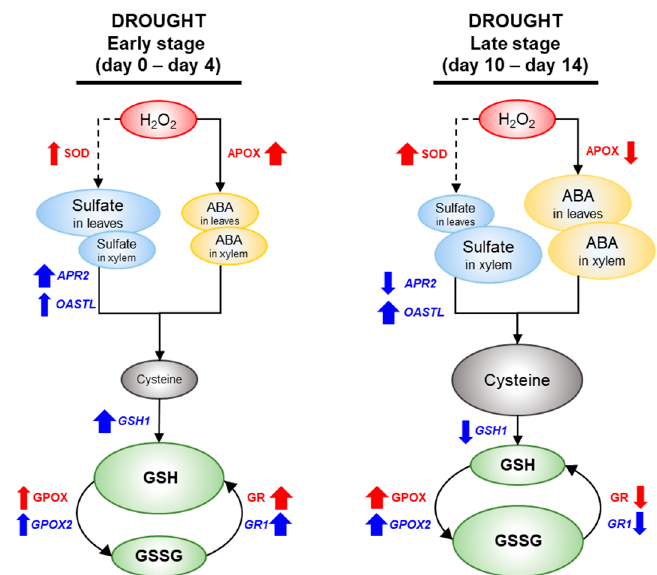
Figure 5. Schematic diagram for the proposed interactive regulation of sulfate to ABA-mediated regulation of sulfur assimilation and GSH redox in two distinct phase of drought intensity. Changes in metabolites, enzyme activities, and gene expressions in related to ROS scavenging, ABA, sulfur assimilation and GSH-based redox status are indicated by black, red, and blue letters, respectively. The circle size indicates the amount of metabolites. The thickness of the arrow indicates the strength of induced or depressed response.